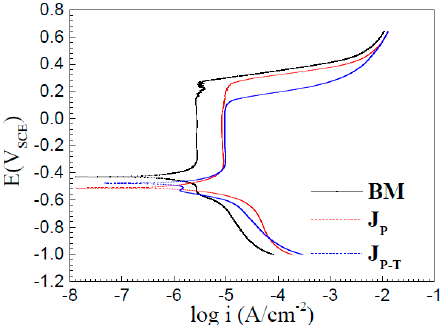
Figure 4. Potentiodynamic polarization behavior of BM, J P , and J P-T in 1 M NaCl solution at room temperature. Table 3. Electrochemical parameters calculated from polarization curves in 1 M NaCl solution at room temperature.